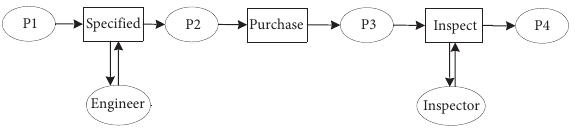
Figure 5: Subprocess of PART0030 and PART0033.